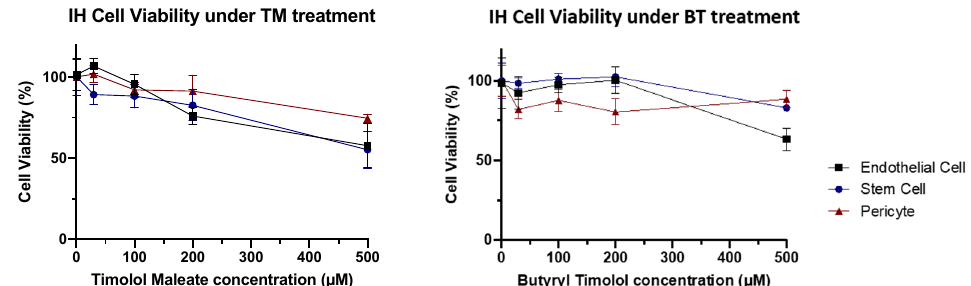
Figure 6. IH cytotoxicity assay. Cell viability tended to gradually reduce as higher concentrations of TM and